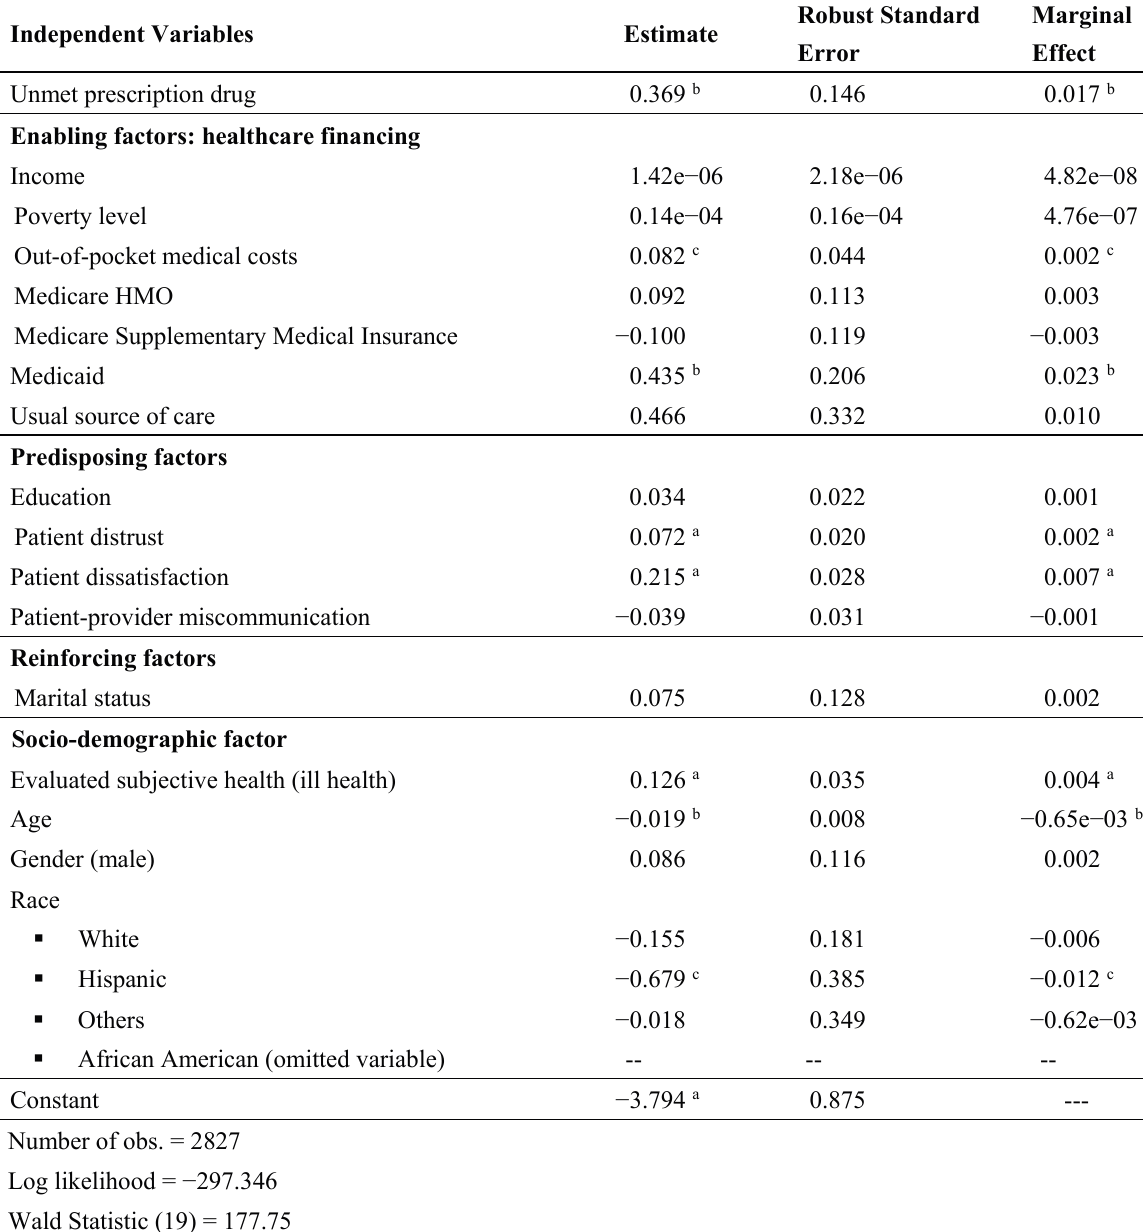
Table 4. Generally perceived unmet needed healthcare: Results of probit estimation (aged